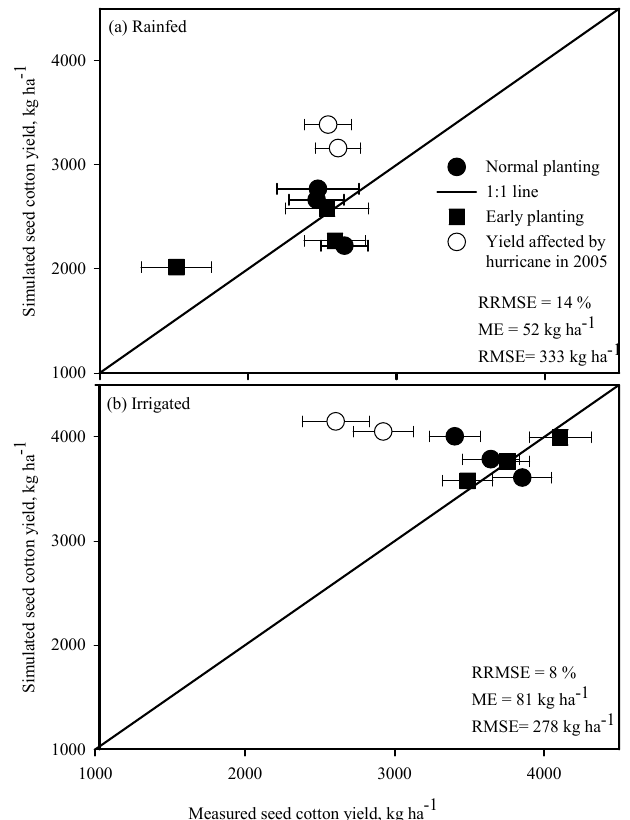
Figure 4. Measured and simulated seed cotton yield of normal and early plantings under rainfed ( a ) and irrigated ( b ) conditions during 2005–2008 at Stoneville, MS. Error bars indicate one SD from the mean of the measured yield across the four treatment replications.